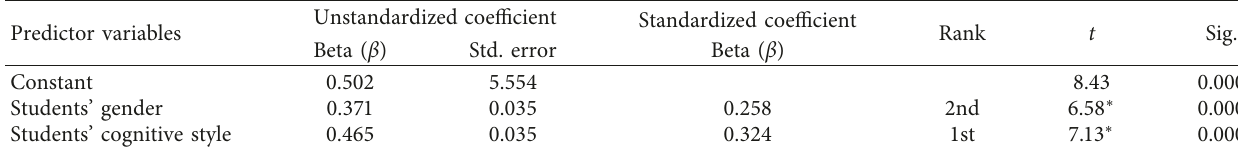
Table 3: Relative contribution of independent variables on students’ achievement in summary writing. Predictor variables